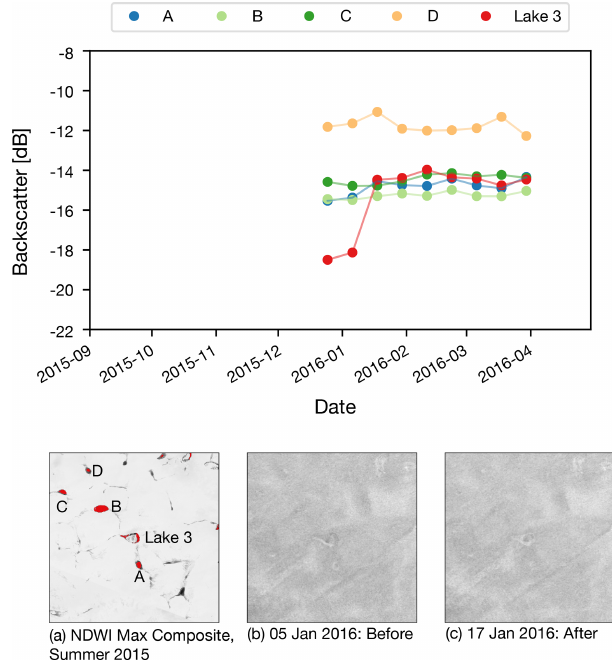
Figure D3. Lake 3 surrounding